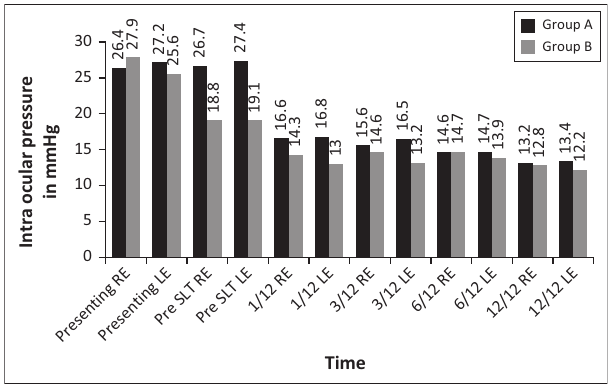
FIGURE 2: Mean intraocular pressure in Group A versus Group B.